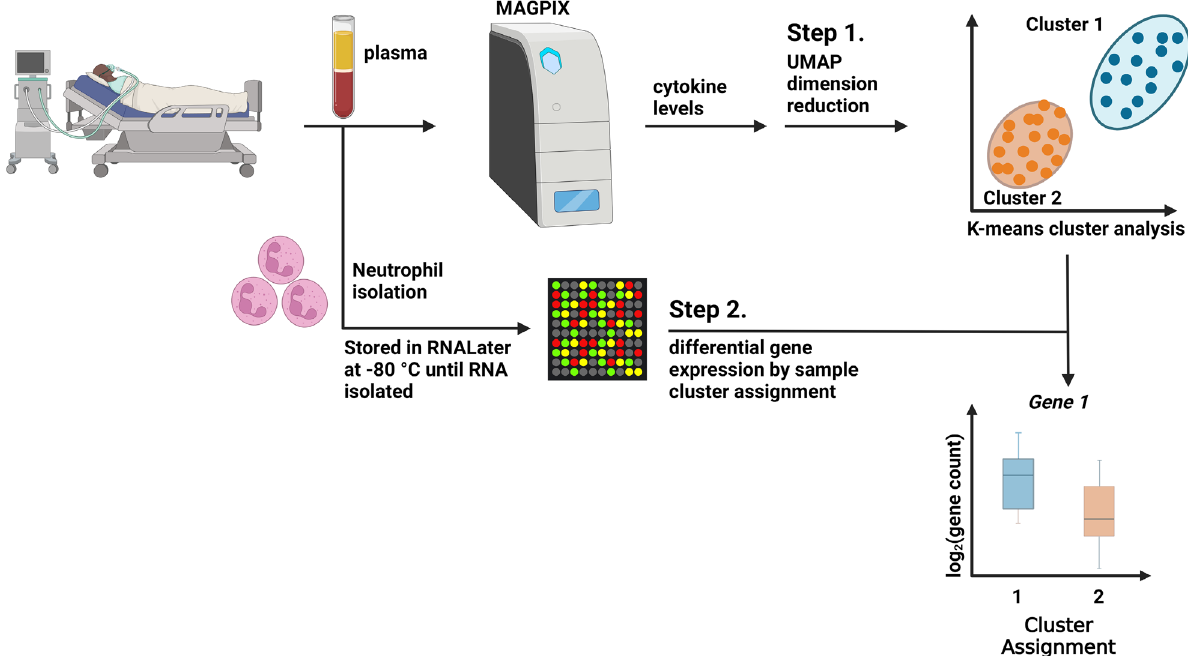
Figure 1. Experimental overview and sample processing. Plasma cytokines were analyzed on a Luminex MAGPIX system (Millipore) using a 21-plex human T cell Panel array (HSTCMAG 28SK, Millipore) according to the manufacturer’s protocol. Following UMAP dimension reduction (Step 1), k-means clustering was used minimize within-cluster sum of squares and Silhouette analysis was performed to yield two clusters of differentially expressed plasma cytokines. Neutrophils were also isolated by negative magnetic bead selection from children ages 6–17 years admitted to the pediatric intensive care unit for an asthma exacerbation, resuspended in RNALater, and stored at − 80 °C until analysis using the Human Immunology v2 NanoString nCounter Gene Expression CodeSet. In Step 2, the differential gene expression of baseline neutrophils was analyzed using the two clusters defined by the plasma cytokine cluster analysis shown in Step 1. Created with BioRender.com with a confirmation of publication and licensing